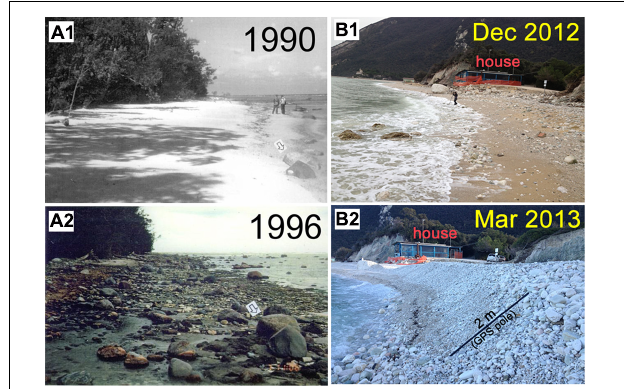
FIGURE 2 | (A1,2) Comparison of the same beach portion of Ruhnu Island (Estonia) after 6 years (modified from Aps et al., 2014) and (B1,2) the same beach portion in Portonovo (zone 4) after 3 months. The beach portion of Portonovo is shown after two storms driven from opposite directions ( B1 storm from NE, B2 storm from SE). The high dynamism associated both with burial and the variation of sediment size can be noticed comparing all the frames.